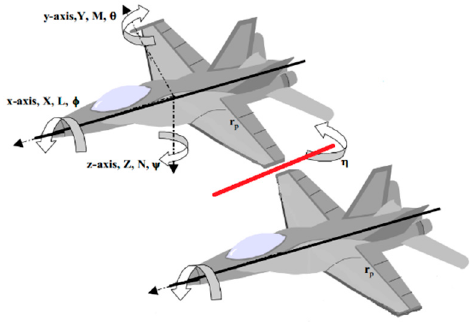
Figure 3. Motion analysis of the composite aircraft multibody system.